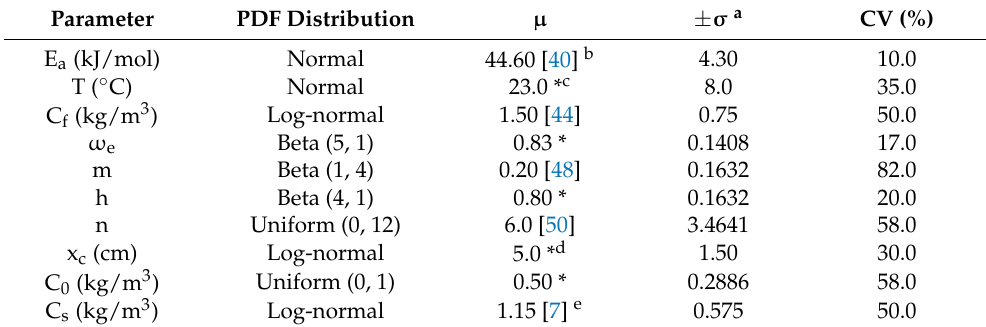
Table 2. Random variable